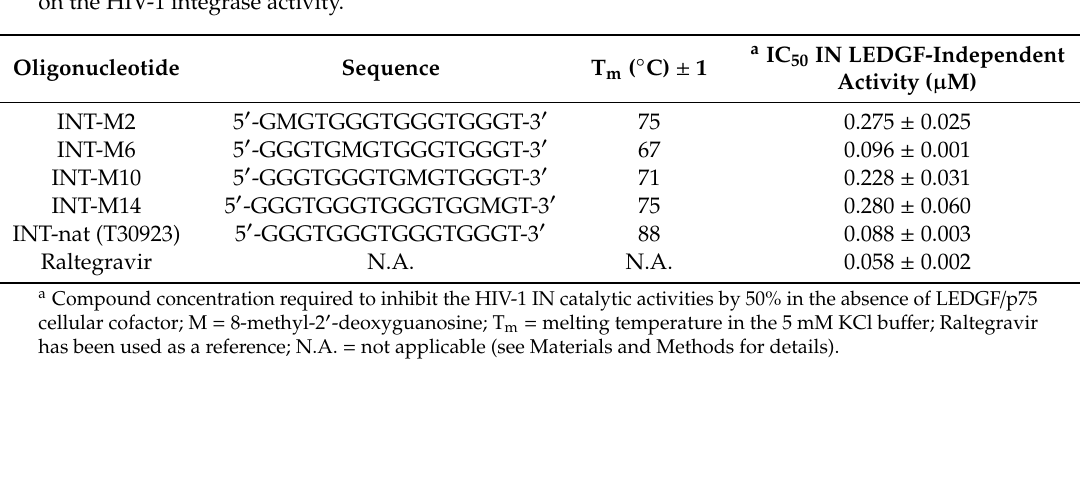
Table 1. Sequence, melting temperature (T m ) and e ff ect of the modified oligodeoxynucleosides (ODNs) on the HIV-1 integrase